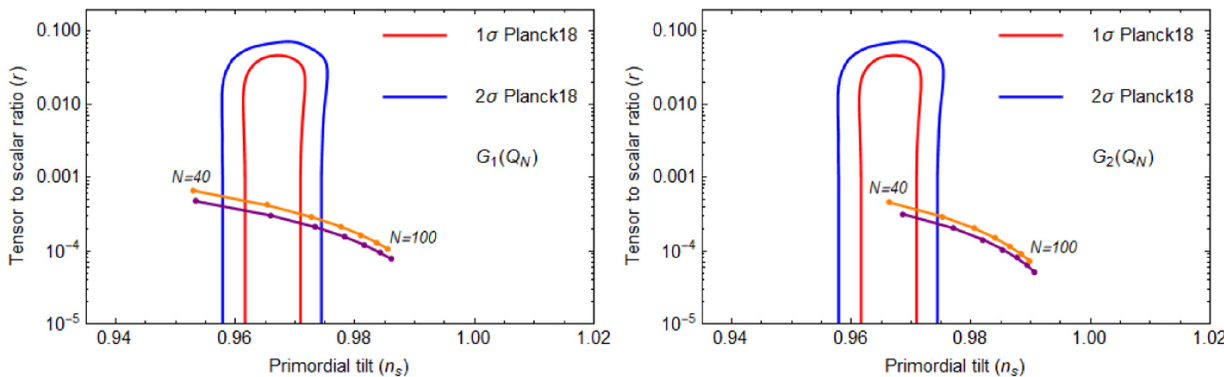
Fig. 3 We compare the theoretical predictions of ( r , n s ) in the strong limit Q >> 1 including the growing mode effect. In each contour, we consider G 1 ( Q N ) (left panel) given in Eq. (3.12) with C r = 70 (purple) and C r = 150(orange);whilst G 2 ( Q N ) (rightpanel)giveninEq.(3.13)